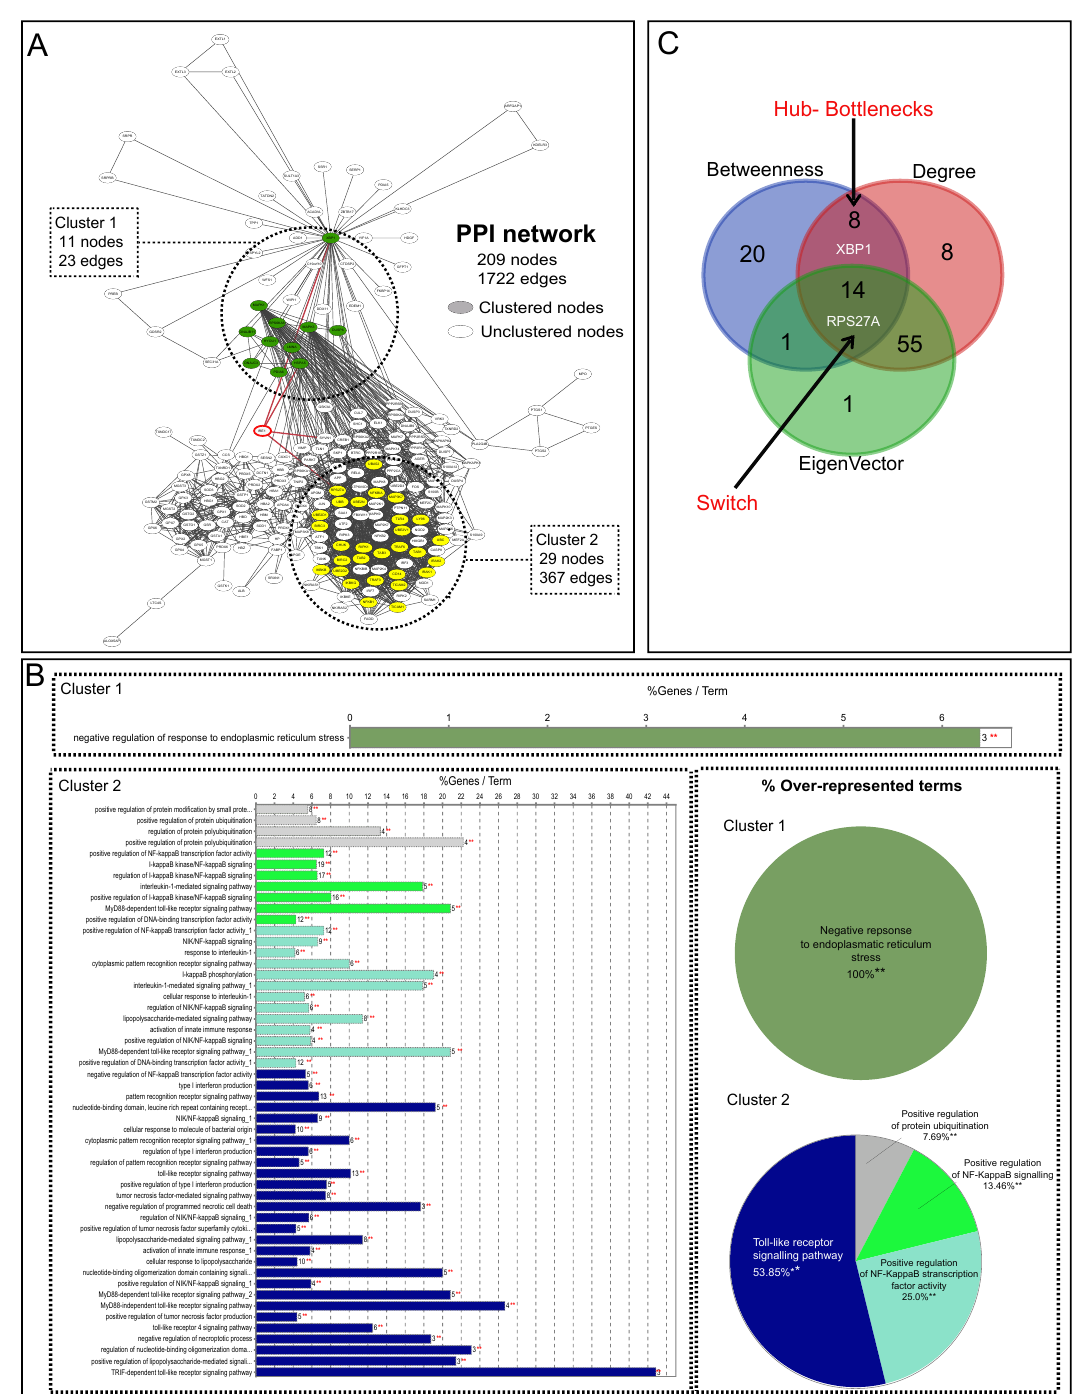
Figure 2. Graph representing PPI network and topological analysis. ( A ): Significant modules from the network are enclosed in dashed lines. These were obtained from MCODE analysis. ( B ): Sub- sequently, GO analysis was performed with ClueGO algorithms. ClueGO results with a pie chart of significant biological findings are represented. Functional enrichment for a given category was assessed by hypergeometric distribution. ( C ): Venn diagram analyzing the PPI network’s degree, betweenness, and eigenvector